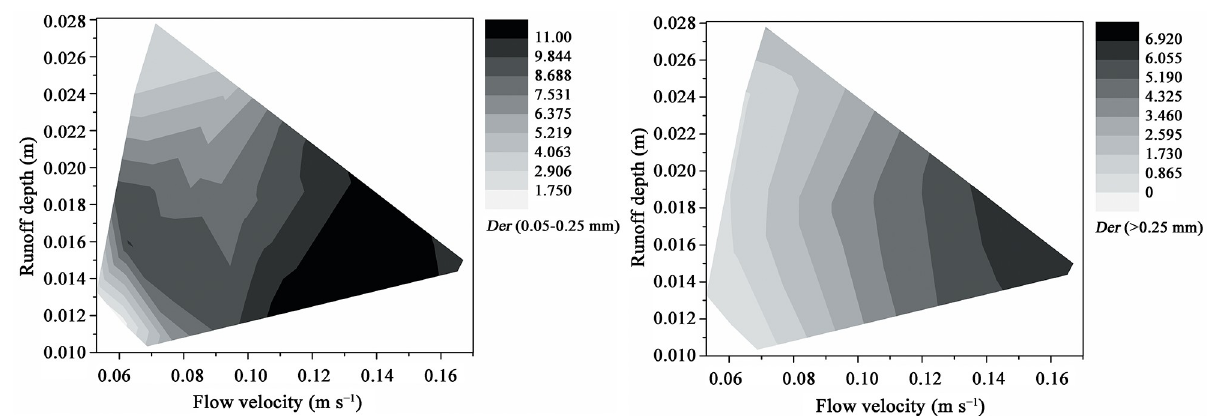
Fig 4. Effects of runoff depth–flow velocity interaction on the differences in the percentages of effective to dispersed ( Der ; %) fine sand (0.05–0.25 mm) or coarse sand ( > 0.25 mm). Der (0.05–0.25 mm) is the difference in the percentages of effective to dispersed 0.05–0.25 mm sediment particles; Der ( > 0.25 mm) is the difference in the percentages of effective to dispersed > 0.25 mm sediment